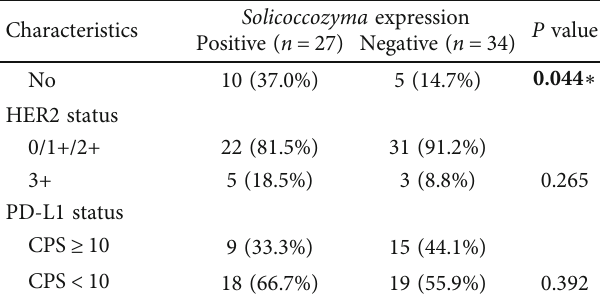
Table 2: Clinicopathological characteristics of Solicoccozyma at the genus level in GC